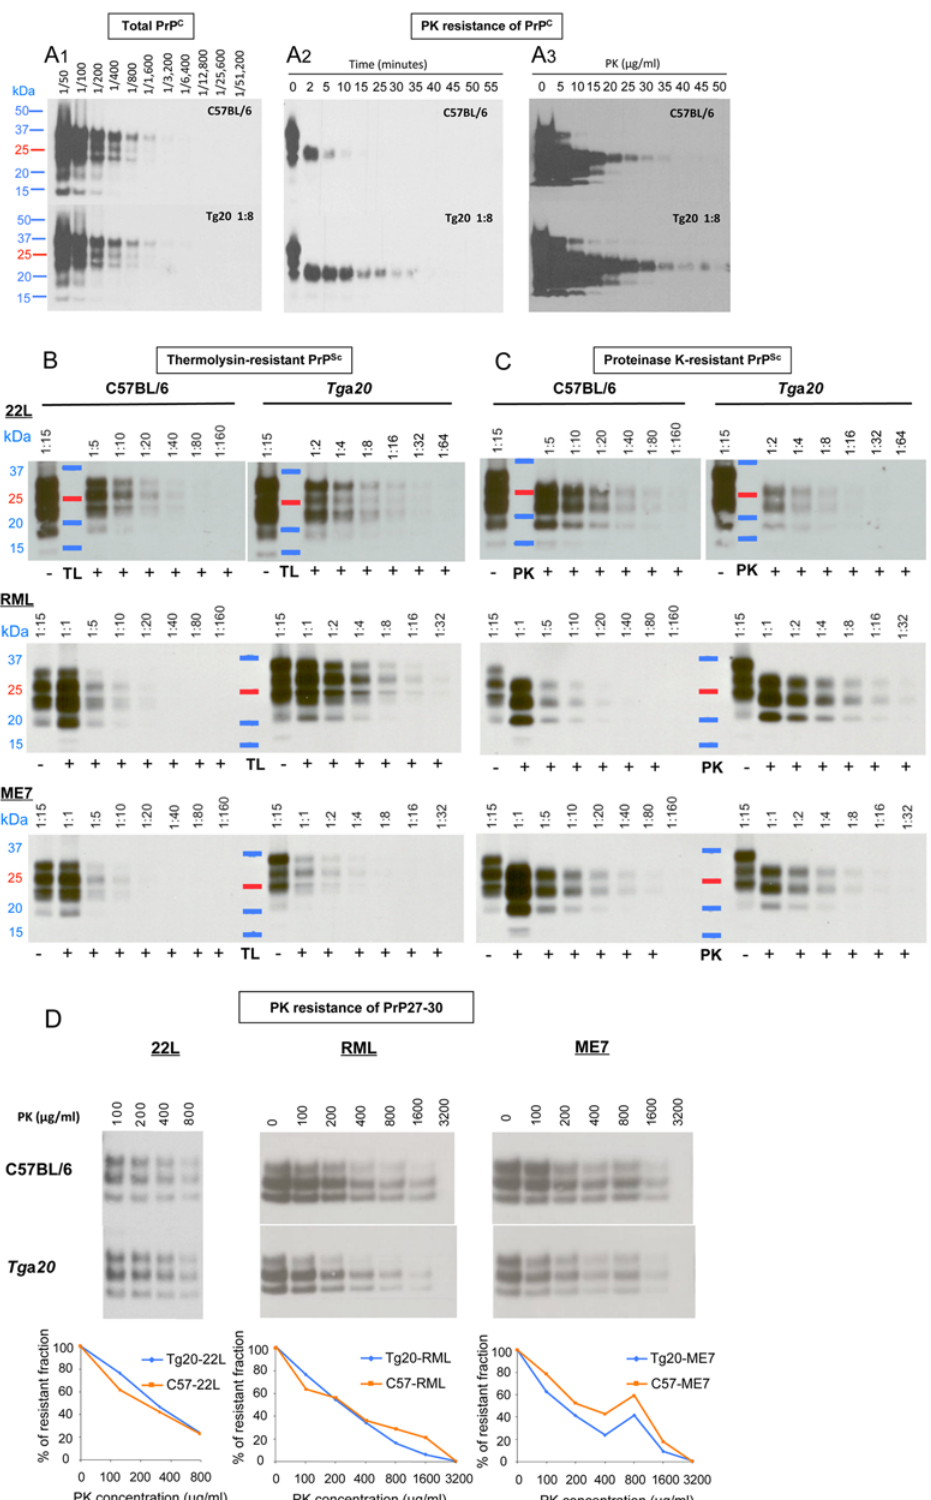
Figure 2. Biochemical analyses of PrP C and PrP Sc from Tg a 20 and C57BL/6 brains. All samples were analyzed by western blotting and the quantification of the blots is summarized in Table 2. A. PK digestion of PrP C . A1: Uninfected Tg a 20 brain homogenates were diluted 1:8 into PrP o/o brain homogenate to adjust PrP C to the same levels as in C57BL/6 homogenates. Serial 1:2 dilutions of the two preparations, compared by western blot analysis, showed indistinguishable PrP C levels. A2: C57BL/6 and 1:8 diluted Tg a 20 brain homogenates were digested for the times indicated with 40 m g PK/ml at 56 u C. A3: The same samples as in (A2) were digested with PK at the concentrations indicated at 37 u C for 60 min. B: Thermolysin digestion of brain homogenates from C57BL/6 or Tg a 20 mice infected with 22L, RML or ME7. Homogenates were treated with 25 m g TL/ml for one hour at 70 u C and